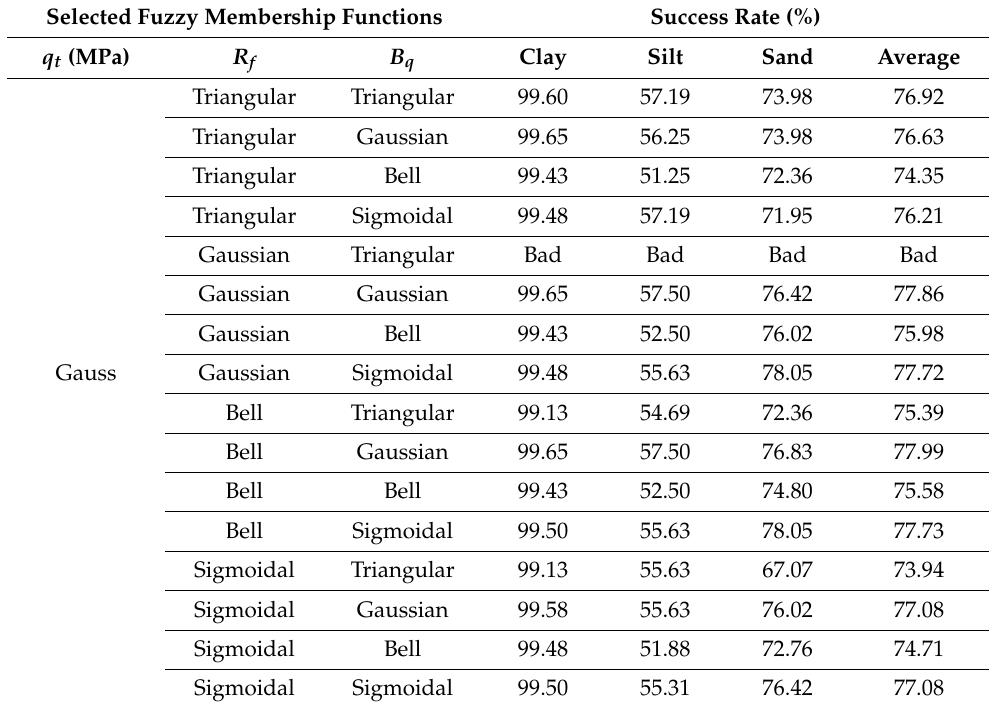
Table 5. Success rate when using a Gaussian membership function for q t . Selected Fuzzy Membership